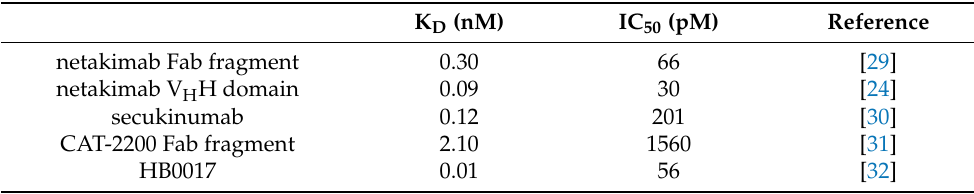
Table 5. IL-17A-specific antibodies. K D for cytokine/antibody complexes and half-maximal inhibitory concentrations are listed.